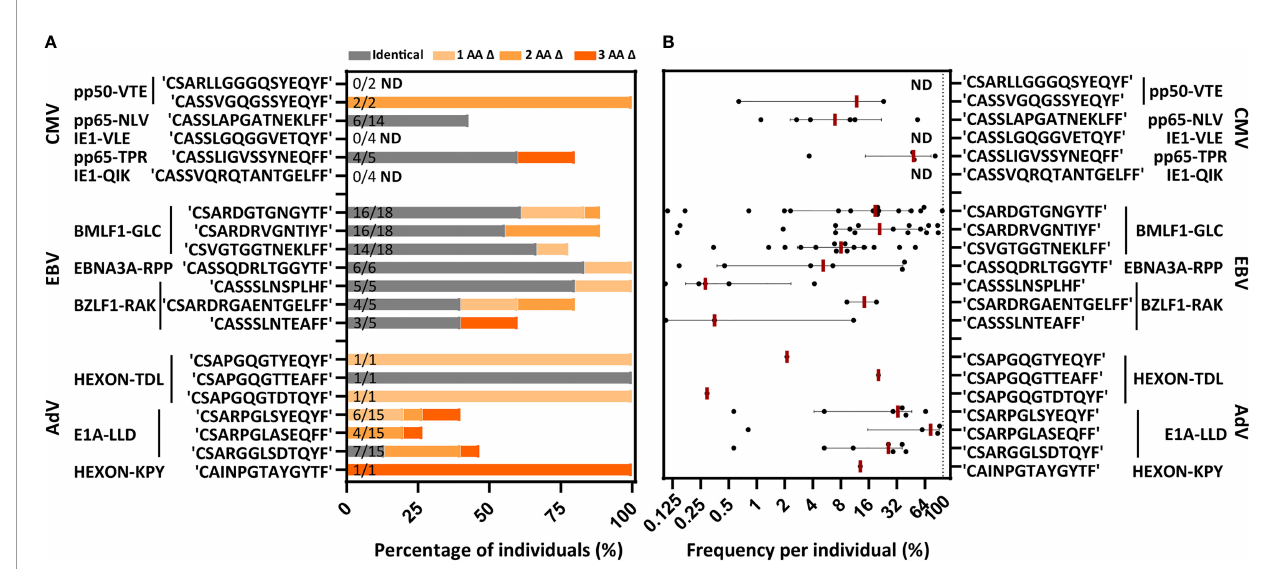
FIGURE 6 | Individuals with a different HLA background from an independent database contain the same PUB-I and PUB-HS CDR3 b AA-sequences. Virus-speci fi c T-cell populations targeting 11 different viral-antigens, derived from an independent database, could be evaluated for the occurrence of PUB-I pr PUB-HS CDR3 b AA-sequences. (A) Nine out of the 11 speci fi cities contained the same PUB-I or PUB-HS CDR3 b AA-sequences as in our database. The occurrence, shown as percentages among healthy donors, is shown per CDR3 b AA-sequence. PUB-I sequences are shown in grey. PUB-HS CDR3 b AA-sequences from other individuals with 1, 2 or 3 AA differences, were stacked on top of the already identi fi ed public-identical sequences. The total numbers of different T-cell populations (different donors) that contained the PUB-I or PUB-HS CDR3 b -sequences are indicated at the inner-side of the y-axis. (B) Shown are the sum of frequencies of the PUB-I or PUB-HS CDR3 b AA-sequences per donor. Each dot is one donor shown and the red-lines represent the medians with interquartile ranges. AA, amino-acid; D , difference(s); ND, Not